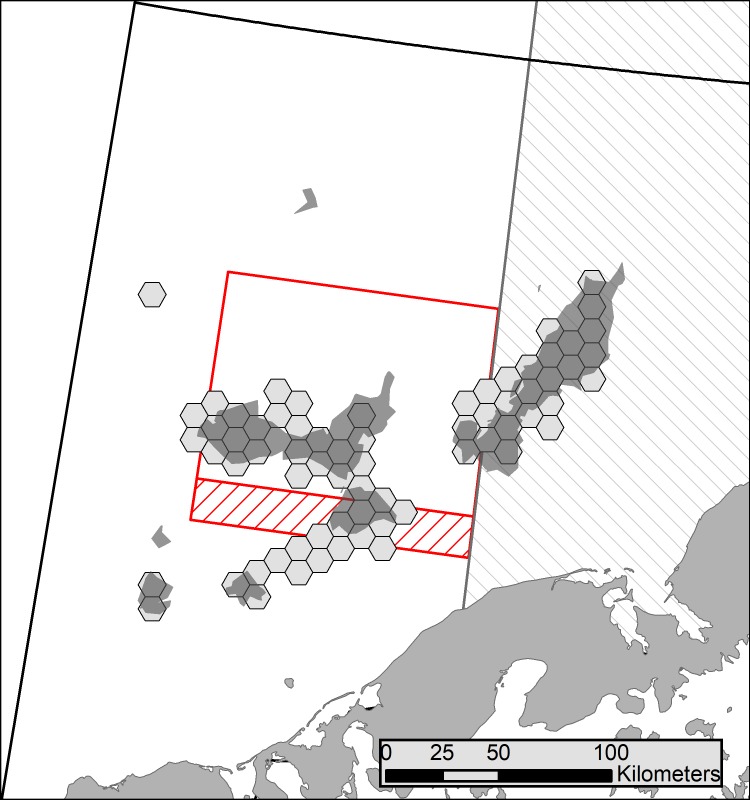
Persistent hot spots and high catch areas for red king crab over 2005–2016.Irregular polygons are hot spots (Getis-Ord, Gi*; Fig 4) that persisted in those areas for at least two years and hexagonal polygons had a high crab catch (≥ 20,00 crab caught; Fig 6) for at least two years. Areas with restrictions on trawling are outlined in red or gray and described in Fig 1.